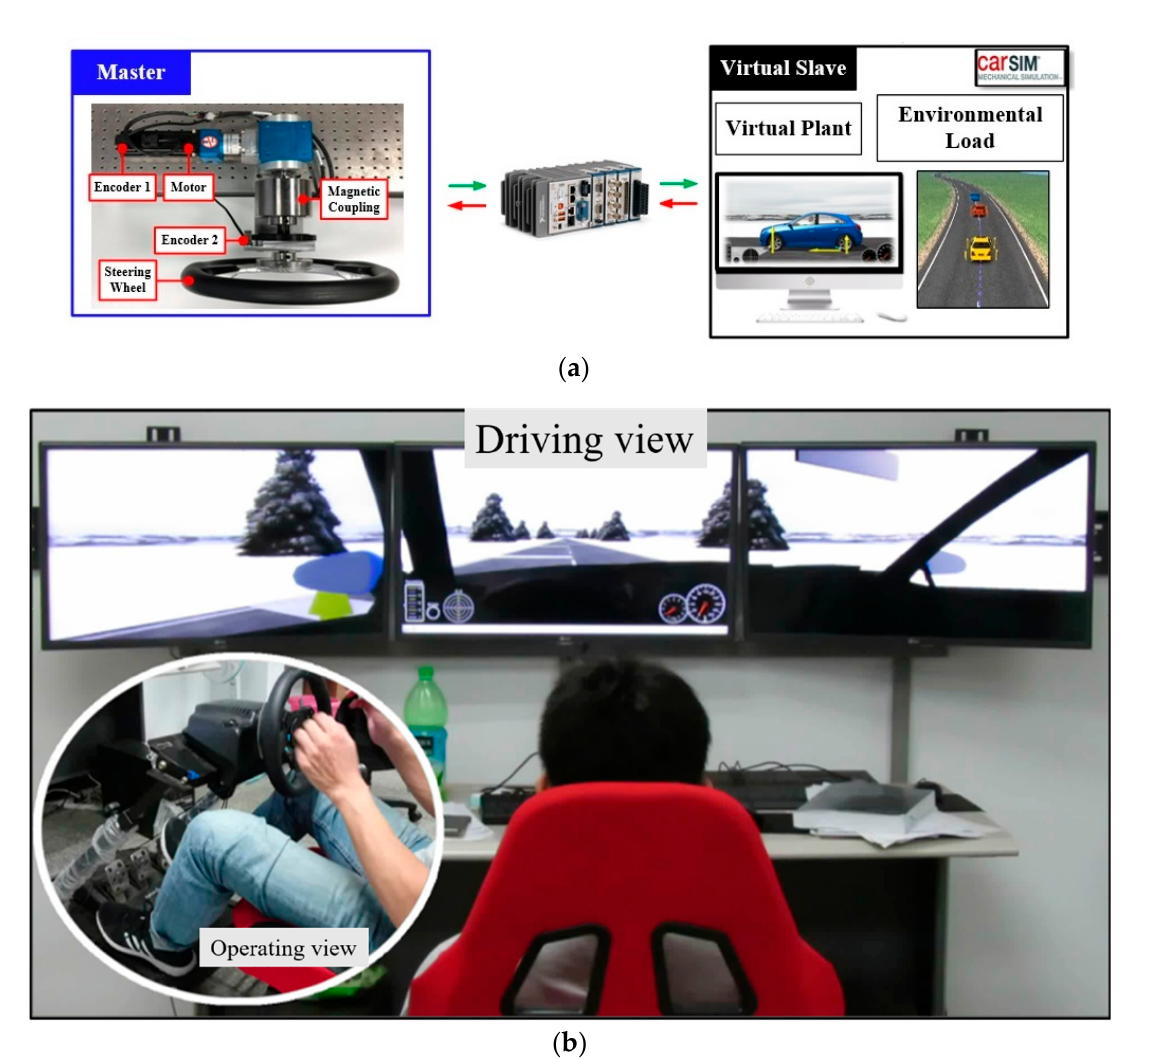
Figure 9. Picture of the ( a ) experimental setup, ( b ) user performing the experiment. Table 1. Parameters of system specifications.